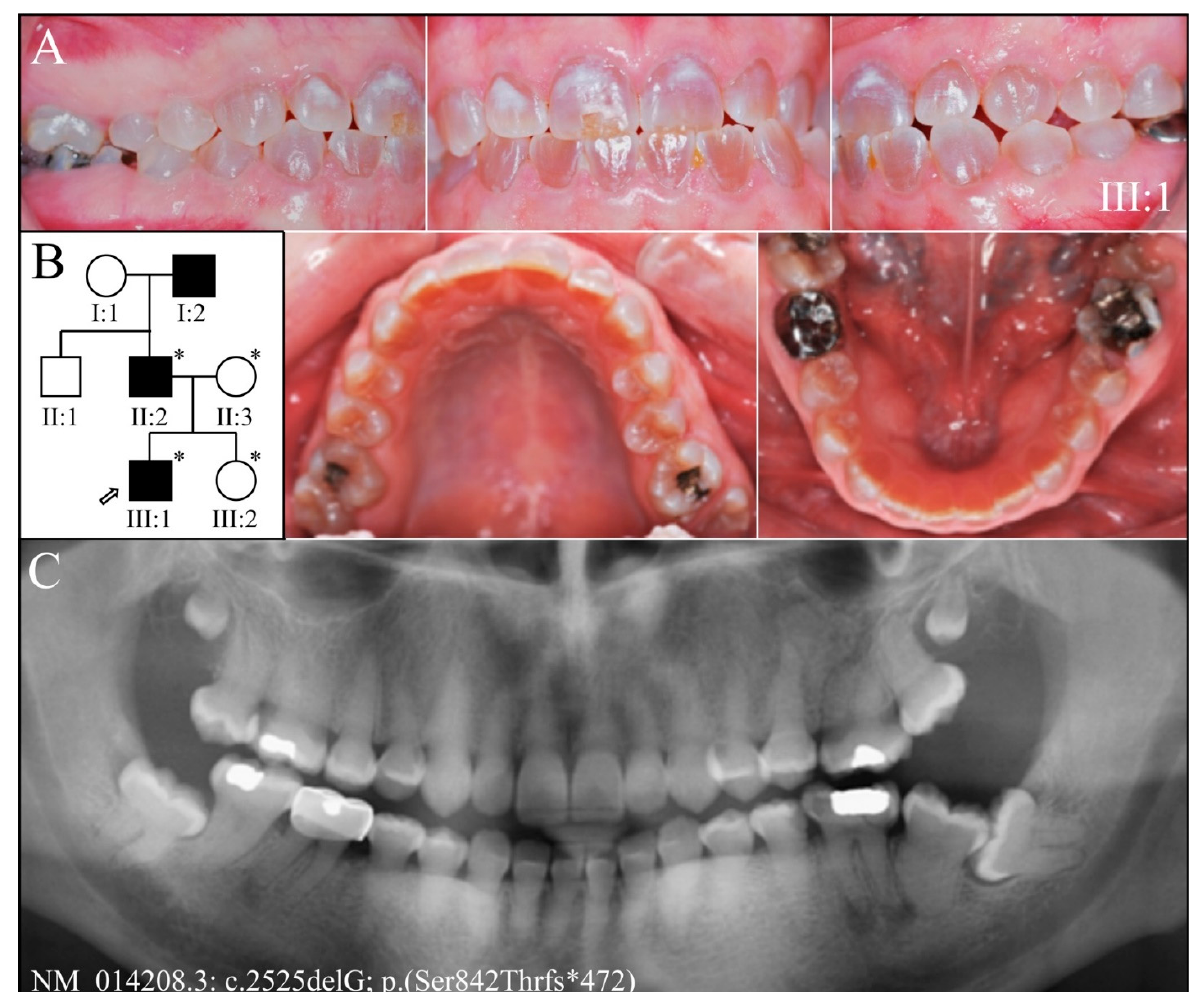
Figure 12. Family 9 from the USA. ( A ): The dental phenotype showed amber-brown discoloration of the permanent dentition without accelerated attrition, except for chipping of enamel on the buccal surfaces of the maxillary central incisor, which was possibly related to malocclusion. ( B ): Three- generation pedigree of the family showing an autosomal dominant pattern of inheritance and iden- tifying the four recruited family members (asterisks). ( C ): The panorex radiograph of the proband (III:1) taken at age 19-years showed obliteration of the root canals, bulbous posterior teeth, short roots on anterior teeth, and enamel of normal thickness. Key : * denotes enrolled participants.